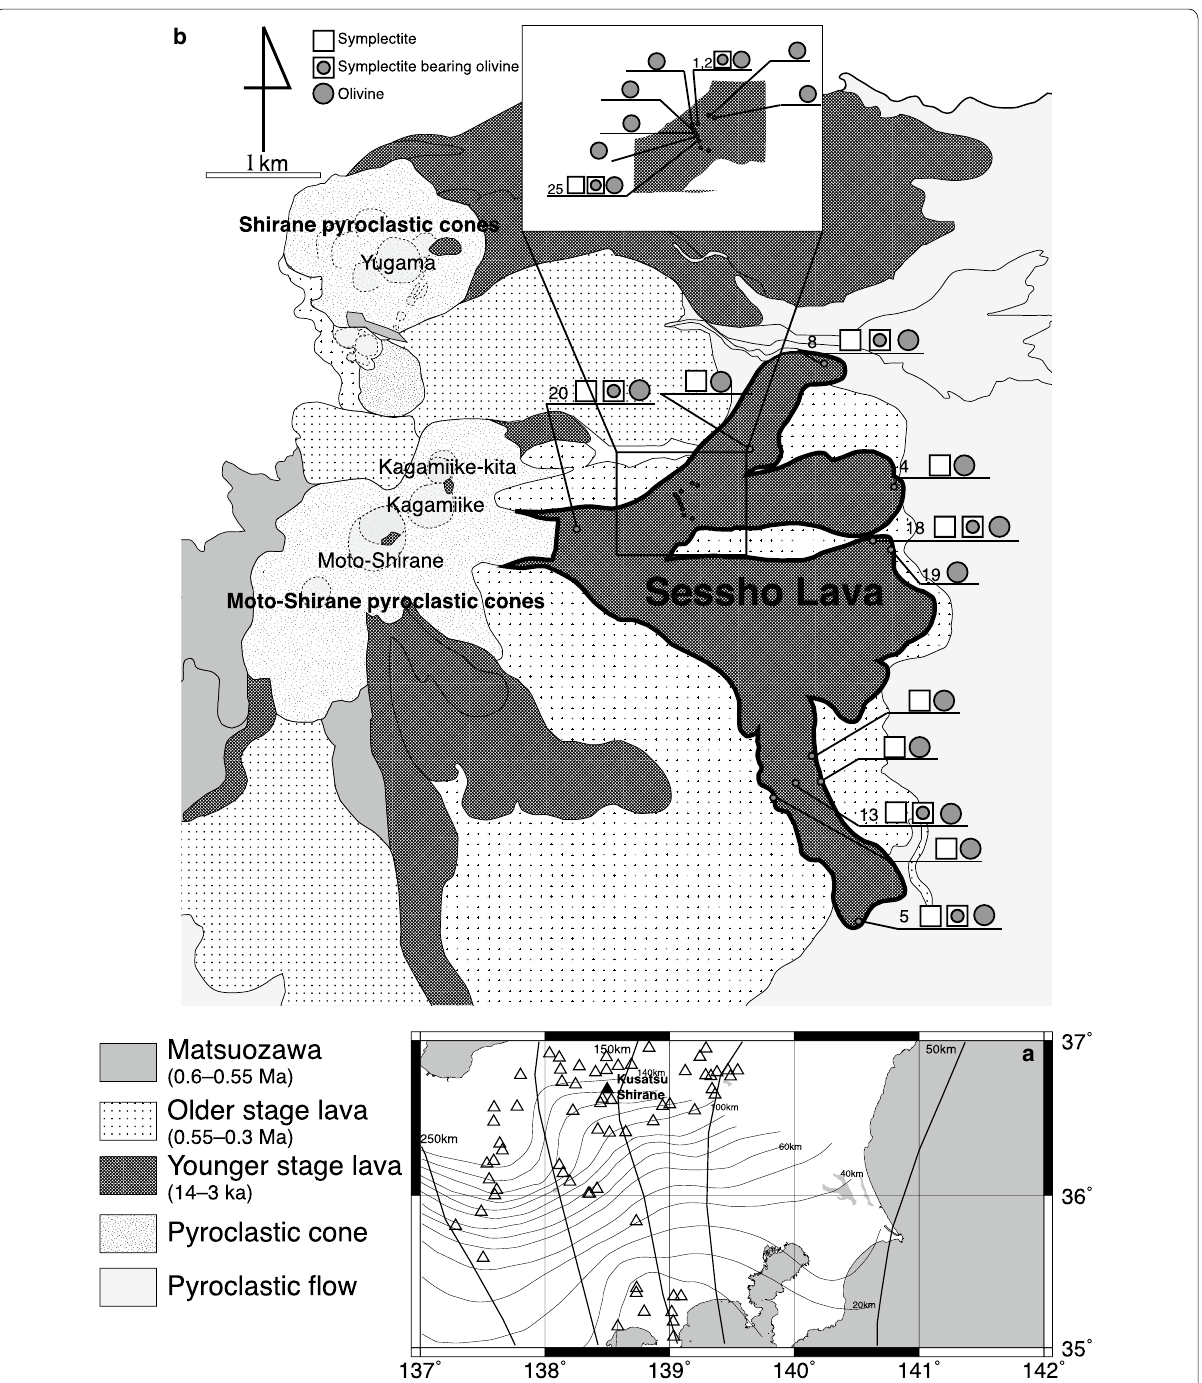
Fig. 1 a Location and simplified tectonic map of Kusatsu–Shirane Volcano, prepared using Generic Mapping Tools (Wessel and Smith 1998). The locations of Quaternary volcanoes (Committee for Catalogue of Quaternary volcanoes in Japan 1999) are shown as triangles. Solid gray and black lines are contours of the depth of the upper surface of the Pacific Plate at 50-km intervals (Nakajima and Hasegawa 2006) and of the Philippine Sea Plate at 10-km intervals (Hirose et al. 2008; Nakajima et al. 2009), respectively (modified after Ueki and Terada 2012). b Geologic map of Kusatsu–Shirane, showing sampling locations, modified by Ueki and Terada (2012) after Uto et al. (1983) and Hayakawa and Yui (1989). The spatial distributions of symplectites and olivine are also shown. The star indicates the location of the bulk sample presented in Table 1. Numbers refer to the samples shown in Figs. 2, 3, 4, 5 and additional